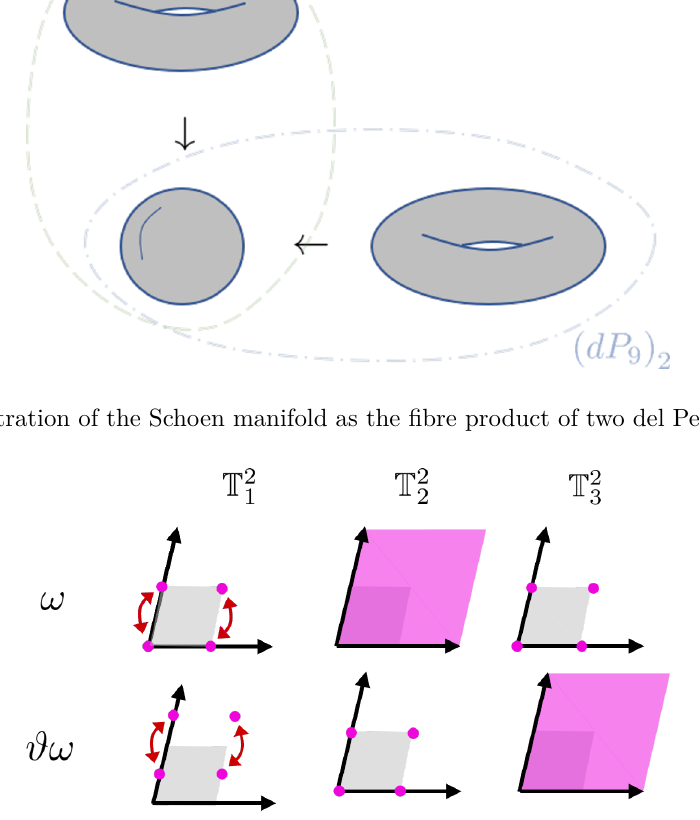
F-theory lift along TTT 2